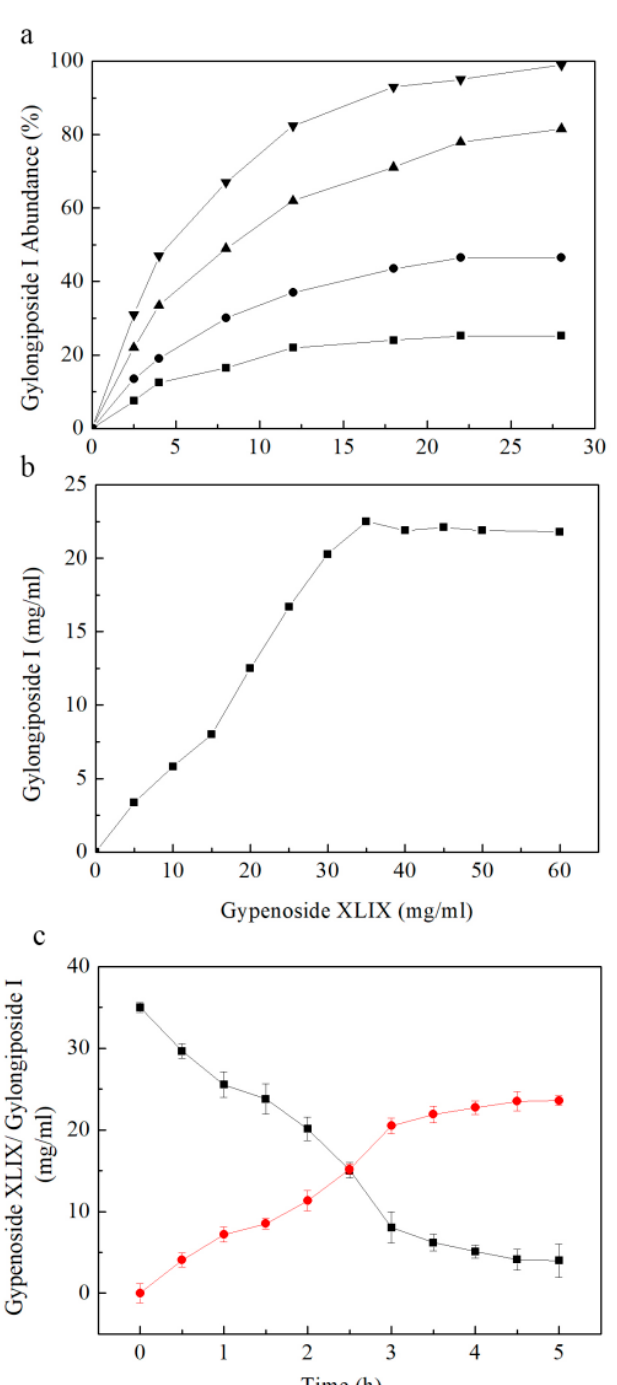
Figure 6. ( a ) Effect of the concentrations of crude enzyme including 2.5 mg/mL enzyme ( (cid:4) ), 5 mg/mL enzyme ( • ), 10 mg/mL enzyme ( (cid:78) ) and 20 mg/mL enzyme ( (cid:72) ) on gylongiposide I production by using the recombinant enzyme. ( b ) Effect of the concentrations of gypenoside XLIX on gylongiposide I production by using the recombinant enzyme. ( c ) Effect of the transformation time on gylongiposide I production ( • ) from gypenoside XLIX ( (cid:4) ) by using the recombinant enzyme.